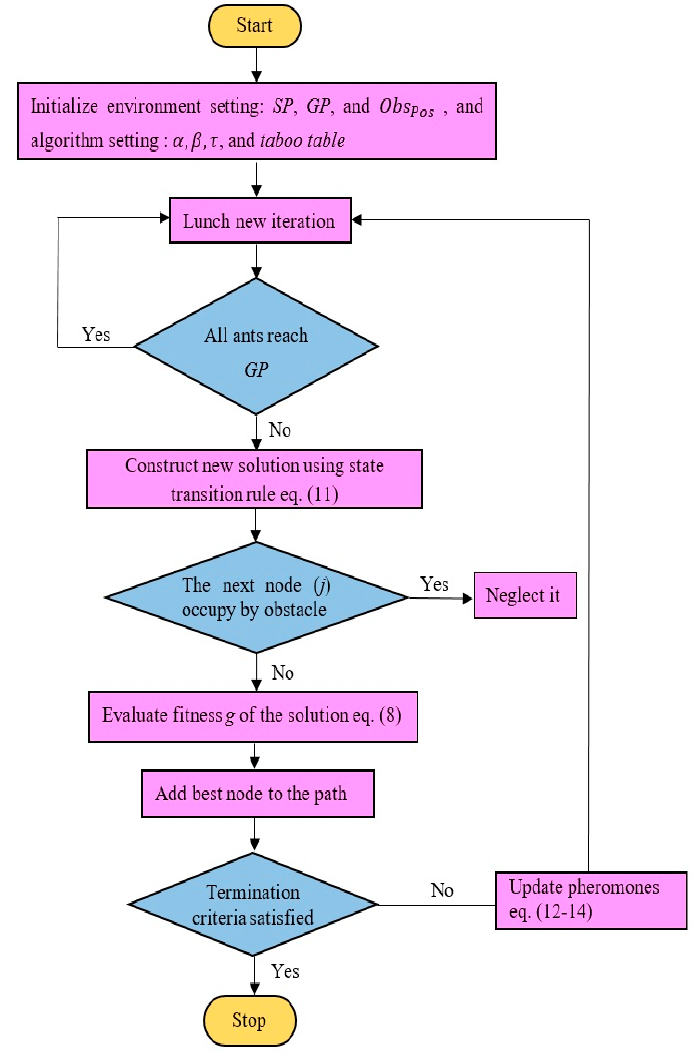
Figure 7. Flowchart of mobile robot path planning in a static environment using AACO.